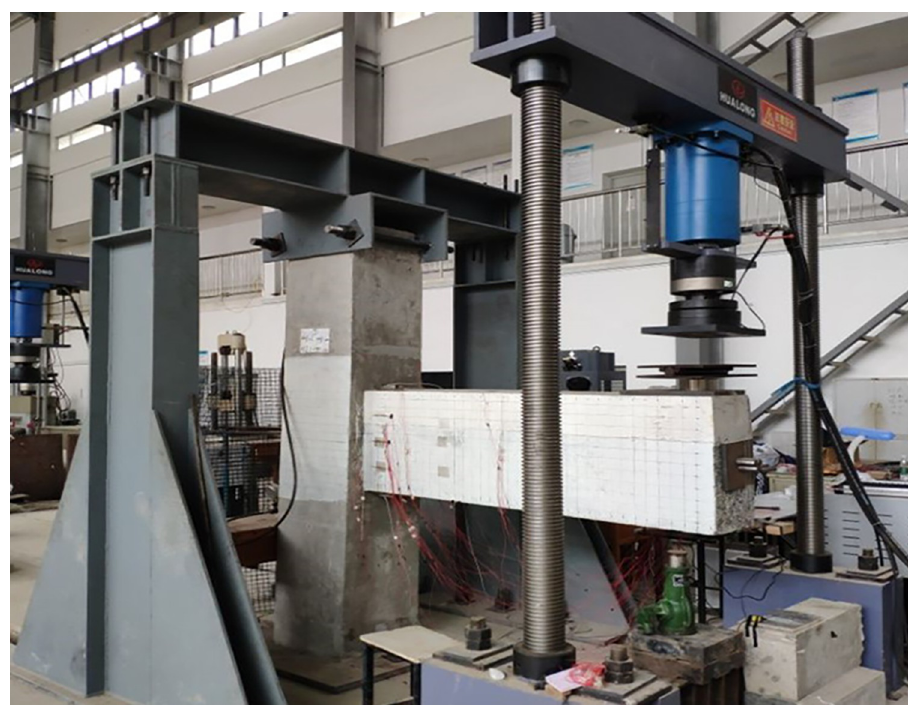
Fig 7. Test loading (front).